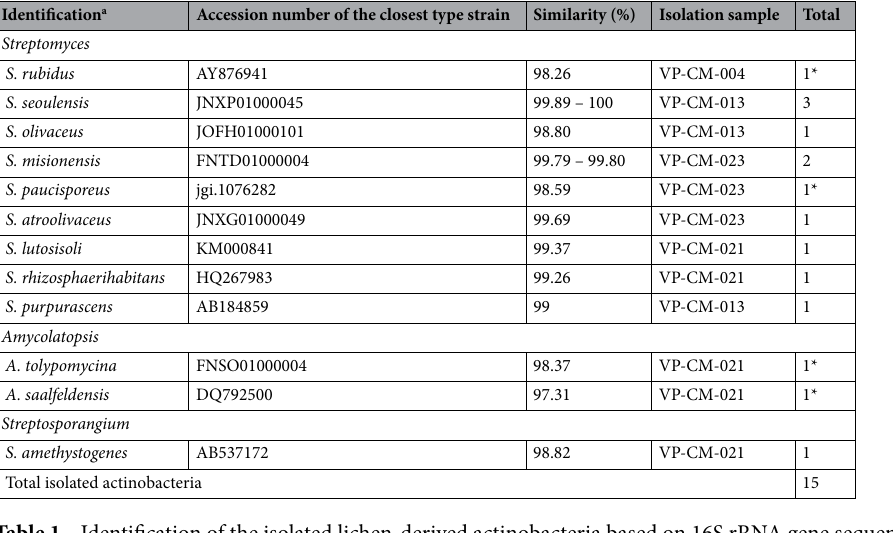
Table 1. Identification of the isolated lichen-derived actinobacteria based on 16S rRNA gene sequence. a nearest match(es). *considered as a novel species.